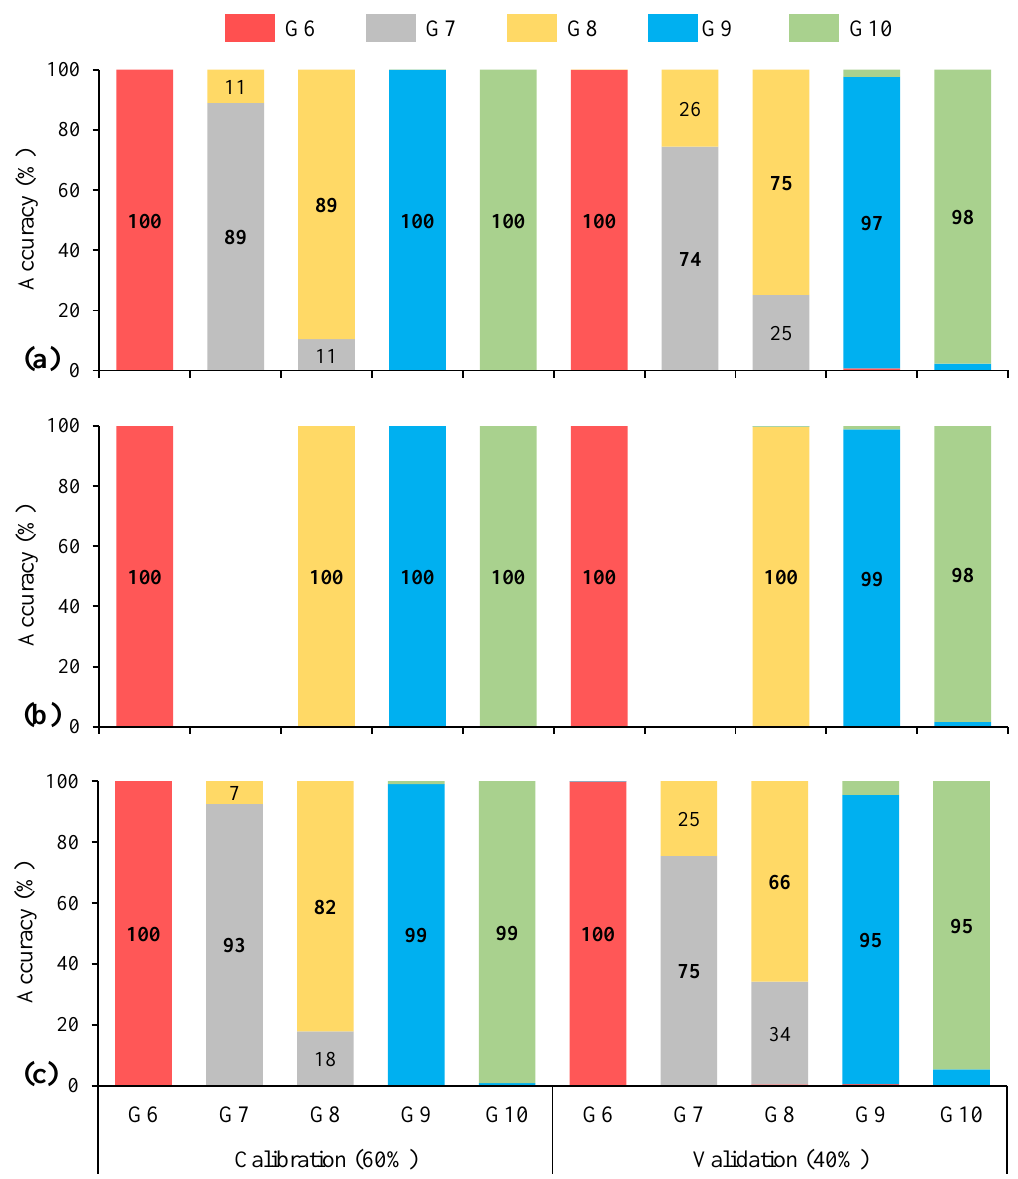
Figure 12. Linear discriminant analysis of Embrapa 2018/2019 [II] ( a ), Unoeste 2018/2019 [II] ( b ), and Embrapa 2018/2019 [II] + Unoeste 2018/2019 [II] ( c ) spectral datasets: percentage of accuracy in the spectral classification of each genotype (bar) relative to all genotypes (colors within the bar) for calibration and validation approaches.